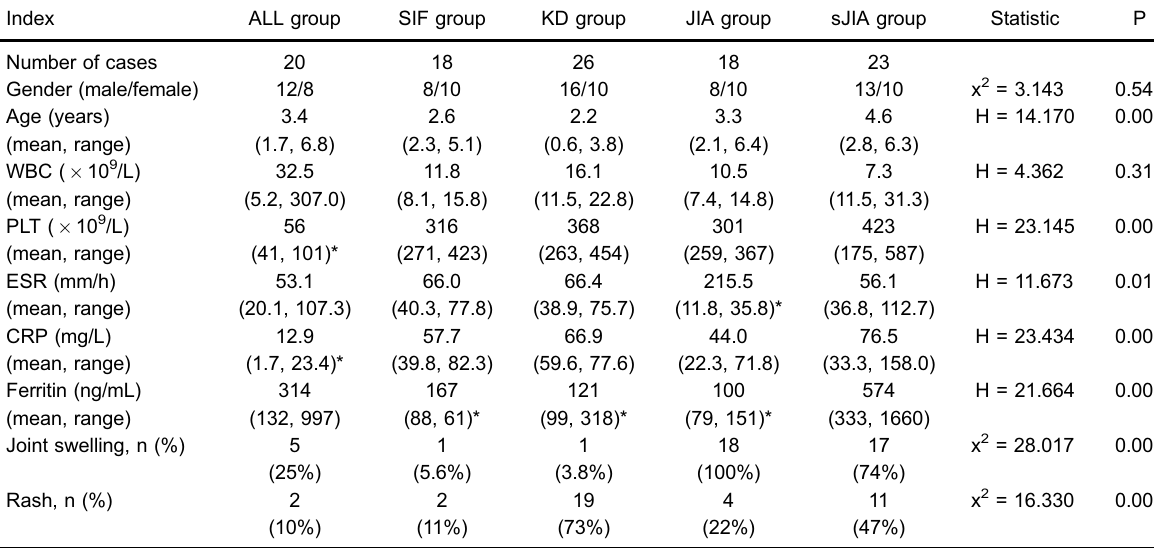
Table 1. Clinical characteristics of all patients.